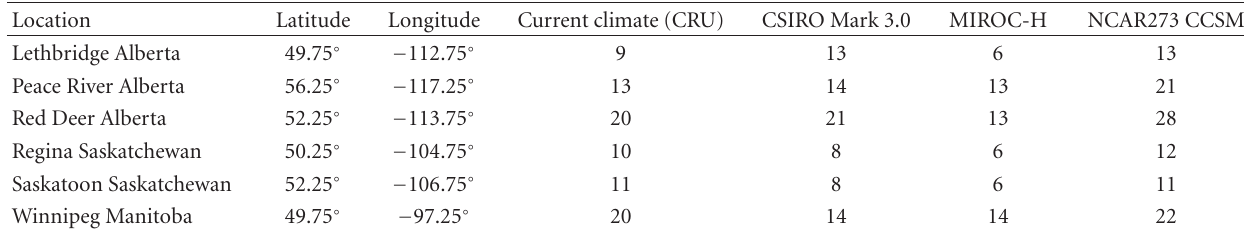
Figure 6: Potential distribution and relative abundance of Sitona lineatus in North America for 2080 as predicted by CLIMEX and the NCAR273 CCSM climate change projection. Dark blue: lakes; Light blue: “Unfavourable” (EI = 0–5); Green: “Marginal” (EI = 5–10); Yellow: “Suitable” (EI = 10–15); Tan: “Favourable” (EI = 15–20); Red: “Very Favourable” (EI > 20). Table 5: Baseline (Current climate: CRU) and General Circulation Model scenarios (CSIRO MARK 3.0, MIROC-H, NCAR273 CCSM) and resulting changes to mean Ecoclimatic Index (EI) values for Sitona lineatus at six defined regions (geographic rectangle, 4 ◦ latitude by 7 ◦ longitude) in western Canada.